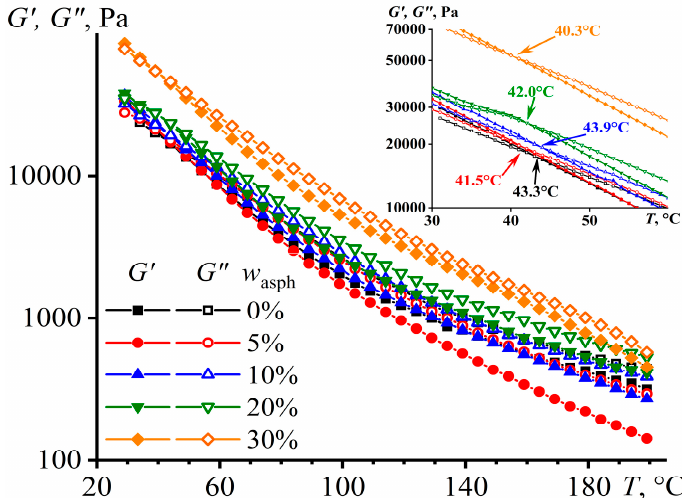
Figure 3. The temperature dependences of storage and loss moduli of PIB and its mixtures with different content of asphaltenes. The inset shows enlarged sections of the same curves, and the arrows indicate the points of equality of the storage and loss moduli.